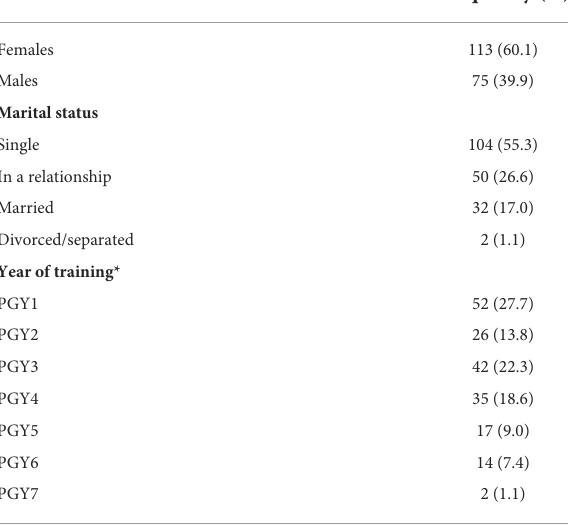
TABLE 1 Demographic characteristics of the trainees ( n =